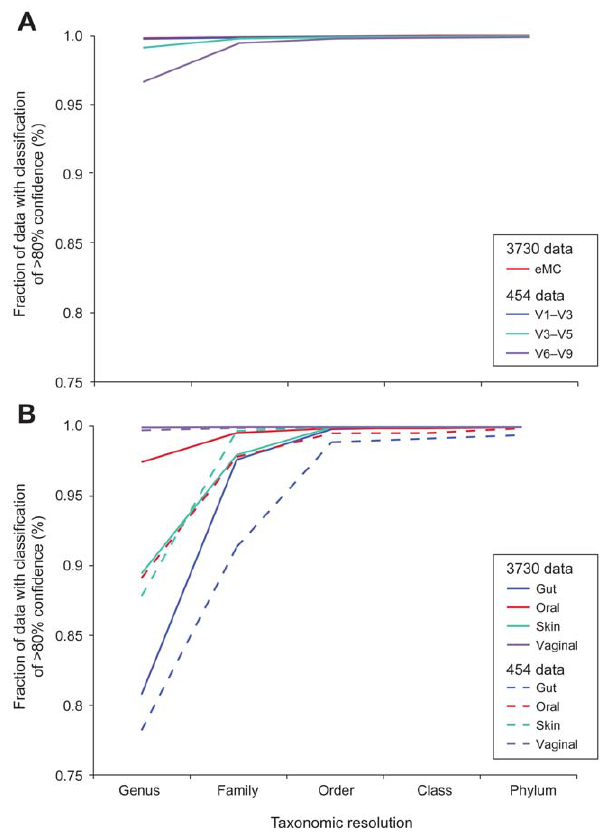
Figure 8. Taxonomic utility of 16S sequence data varies by technology, 16S window, and sample type. The fraction of successfully classified 3730 and 454 sequences obtained from the MC (A) and clinical samples representing four major body regions (B) is plotted at different taxonomic levels from genus to phylum. Classification was performed on quality and chimera-filtered sequences and considered to be successful if the RDP Classifier result had a confidence score above 80%. In panel B, 454 results include only window V3–V5.